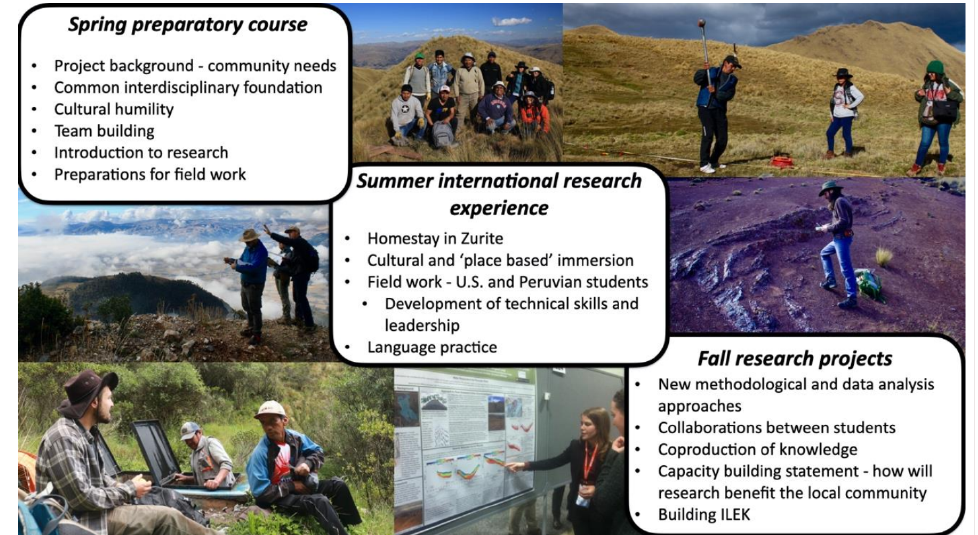
Figure 3. The educational framework for our Bonanza project. We embedded the summer interna- tional research experience within coursework to maximize the impacts and foster sustained